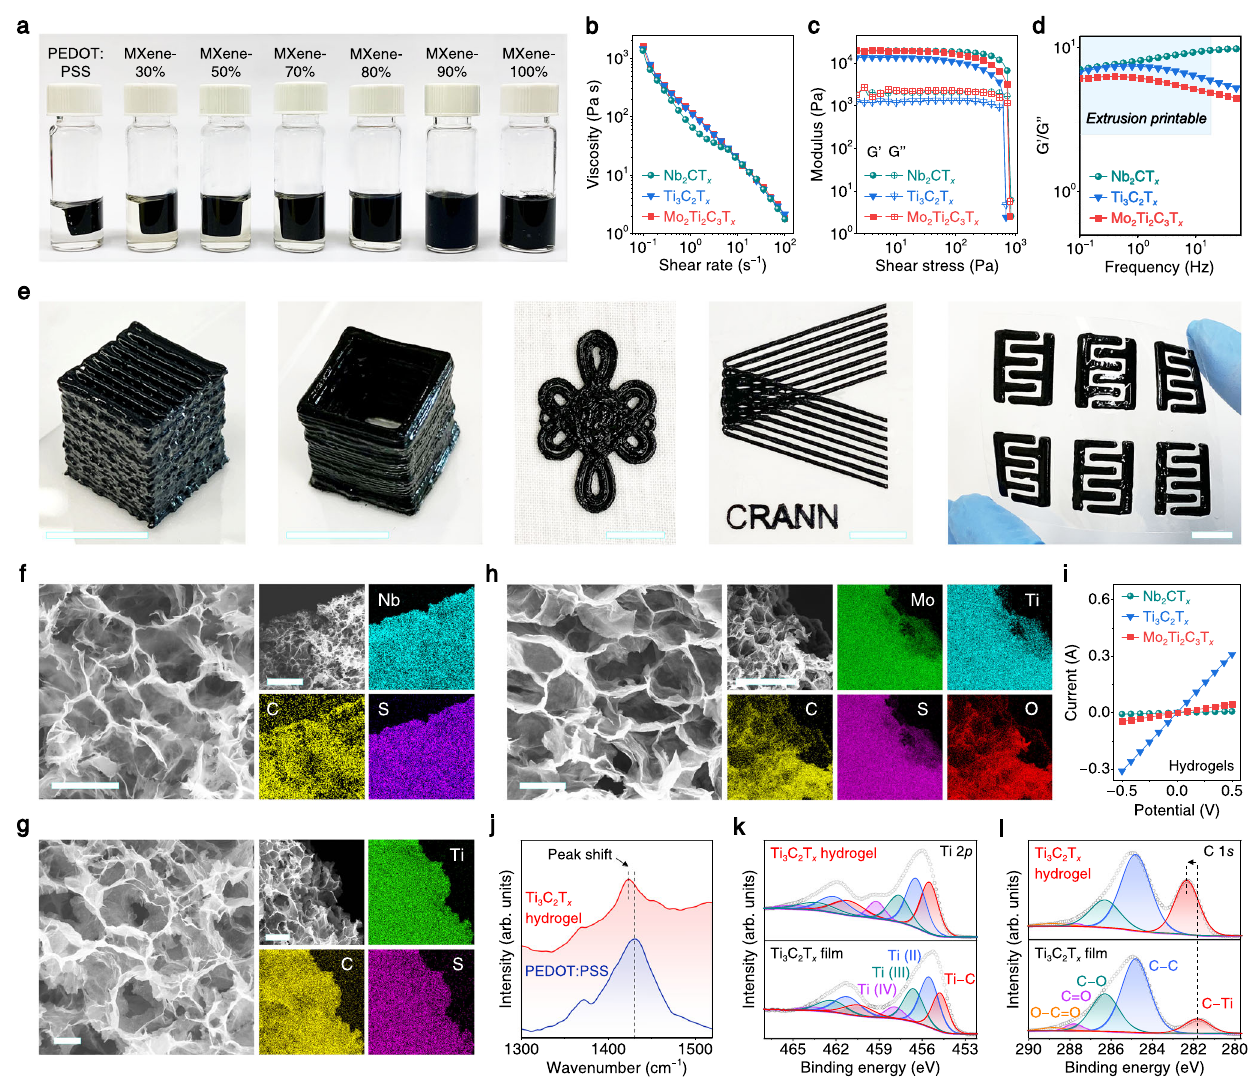
Fig.2|CharacterizationsofMXeneinksandhydrogels.a PhotographsofTi 3 C 2 T x hydrogels with different MXene contents prepared by self-assembly. b Viscosity as a function of shear rate for Nb 2 CT x , Ti 3 C 2 T x and Mo 2 Ti 2 C 3 T x inks. c Storage mod- ulus(G ′ )andlossmodulus(G ′′ )asafunctionoftheshearstressforNb 2 CT x ,Ti 3 C 2 T x and Mo 2 Ti 2 C 3 T x inks. d Frequency dependency of the ratio of the G ′ to G ″ for Nb 2 CT x , Ti 3 C 2 T x and Mo 2 Ti 2 C 3 T x inks. e Photographs of 4D-printed MXene hydrogel architectures (from left to right): Ti 3 C 2 T x hydrogel microlattice on glass slide, Ti 3 C 2 T x hydrogel rectangular hollow prism on glass slide, Nb 2 CT x hydrogel Chinese knot on cloth, Nb 2 CT x hydrogel “ CRANN ” logo on PET fi lm, fl exible